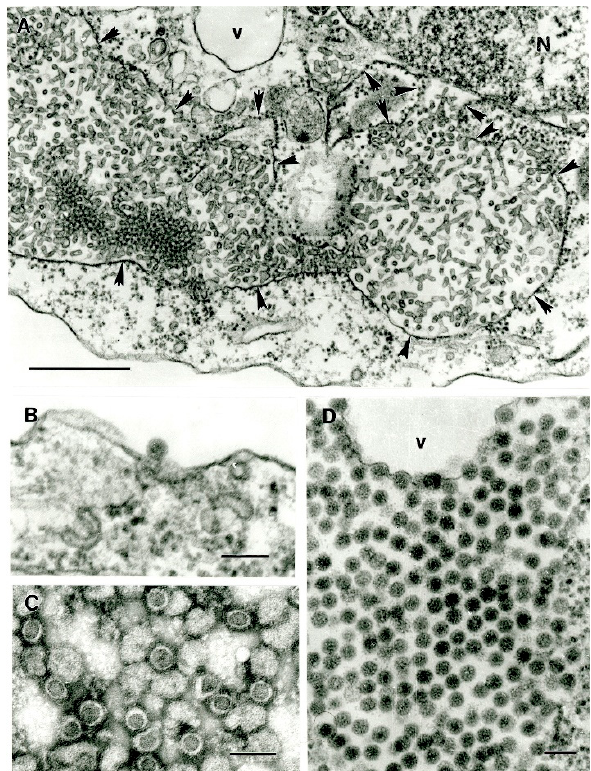
Figure 10. Ultrastructure of insect-specific viruses in insect cell cultures. ( A ) Negev virus (strain EO-239) in C6/36 cells induces enormous expansions of perinuclear space (indicated by arrowheads) filled with short tubules; N- cell nucleus, v – vacuole. Bar = 500 nm. ( B ) Eilat virus virion attached to the surface of C7/10 cell, 1 min post infection. Bar = 100 nm. ( C ) Purified virions of Eilat virus, negative staining with uranyl acetate. Bar = 100 nm. ( D ) Fragment of an intracytoplasmic inclusion of GMC-202 virus in C6/36 cell, presumably a novel Entomobirnavirus, isolated from mosquitoes collected on the Bolivar peninsula, Galveston county, Texas, U.S. Bar = 100 nm.